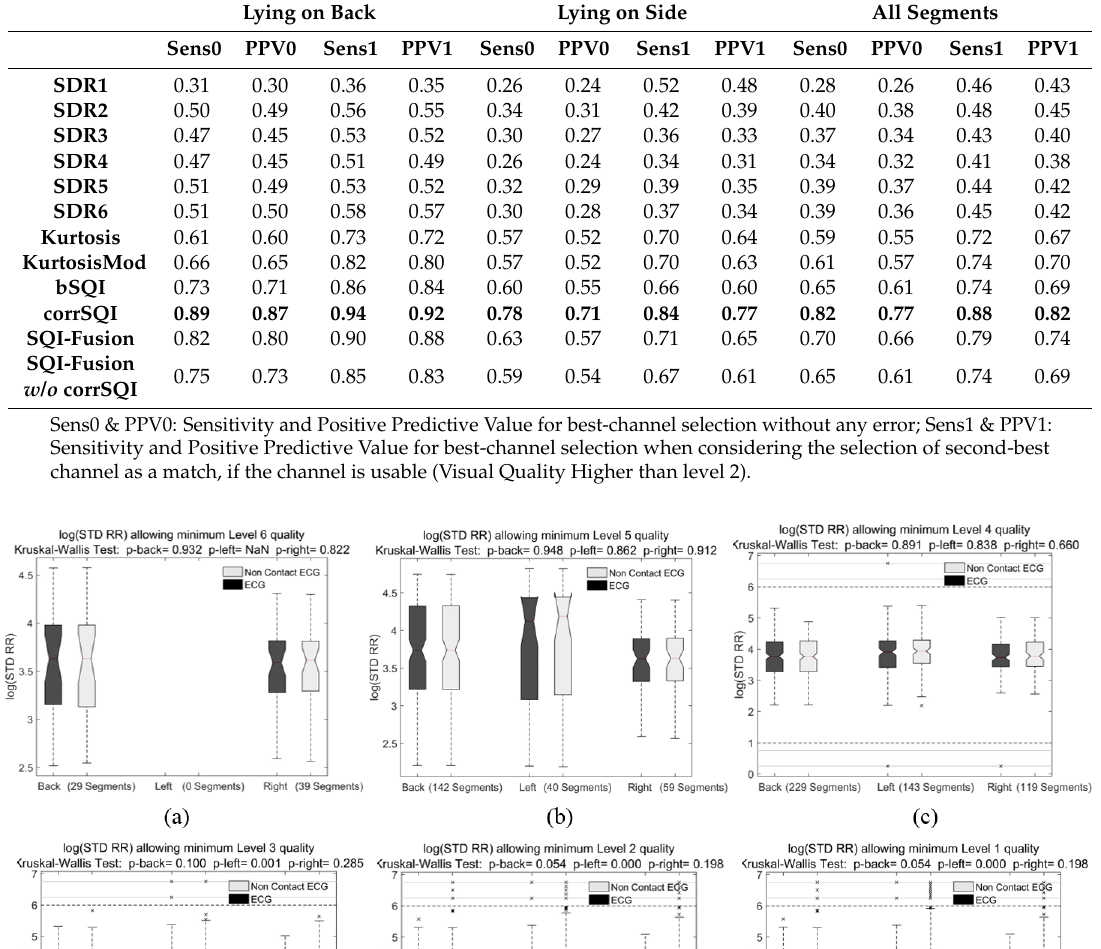
Table 8. Test results for best-channel non-contact ECG selection using signal quality indicators. Lying on Back Lying on Side All Segments Sens0 PPV0 Sens1 PPV1 Sens0 PPV0 Sens1 PPV1 Sens0 PPV0 Sens1 PPV1 SDR1